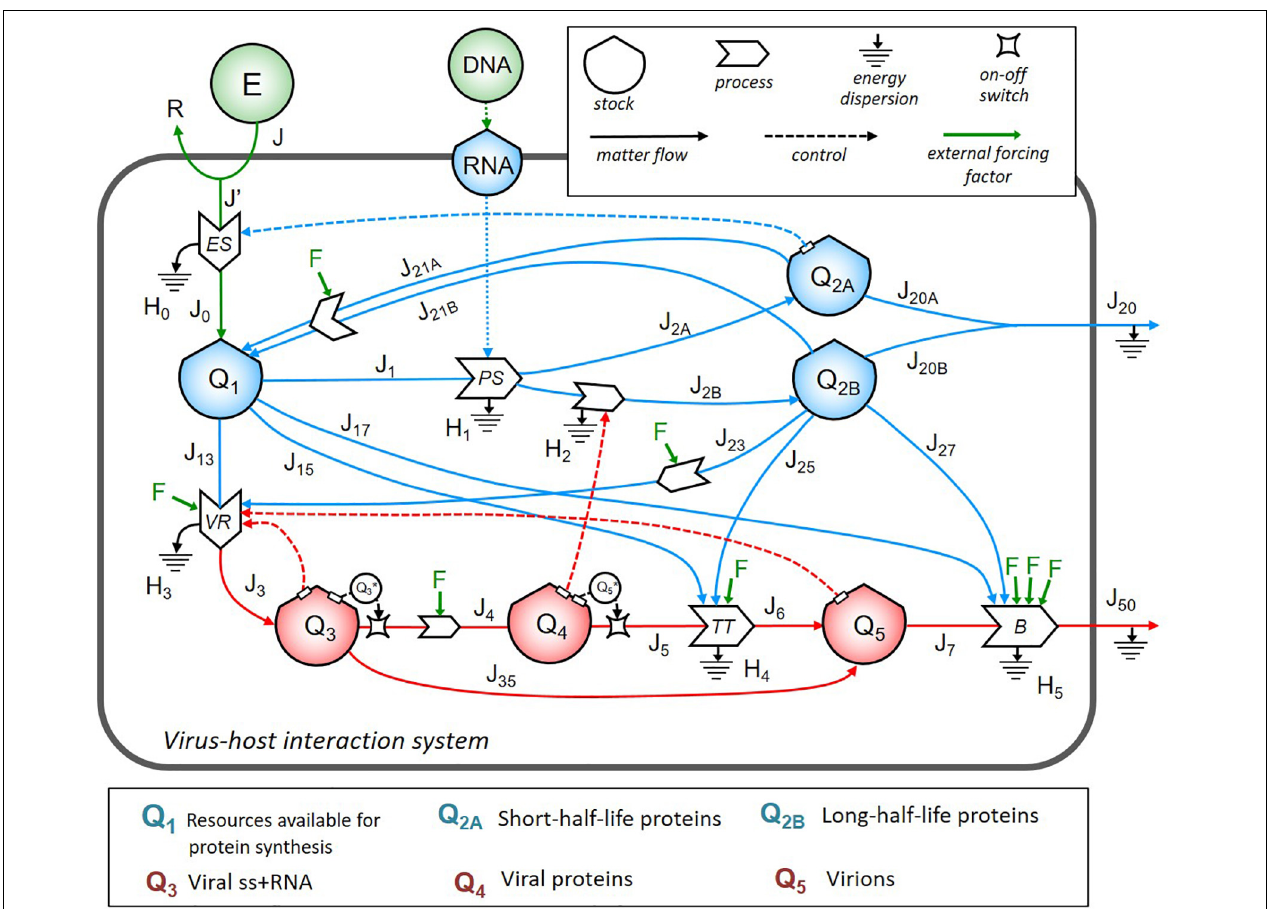
FIGURE 1 | The energy systemic diagram of a cell infected by ss+ RNA virus. Stock-flow diagram of the virus–host interaction system. In the upper right box are the meaning of symbols. The color code is as follows: blue for host cell energy stocks and relative inflows and outflows; red for virus energy stocks and relative inflows and outflows; green for external energy inputs and external driving forces F corresponding to different therapeutic strategies. The lower box lists the biological contents of the stocks, all expressed in terms of energy (ATP-equivalent